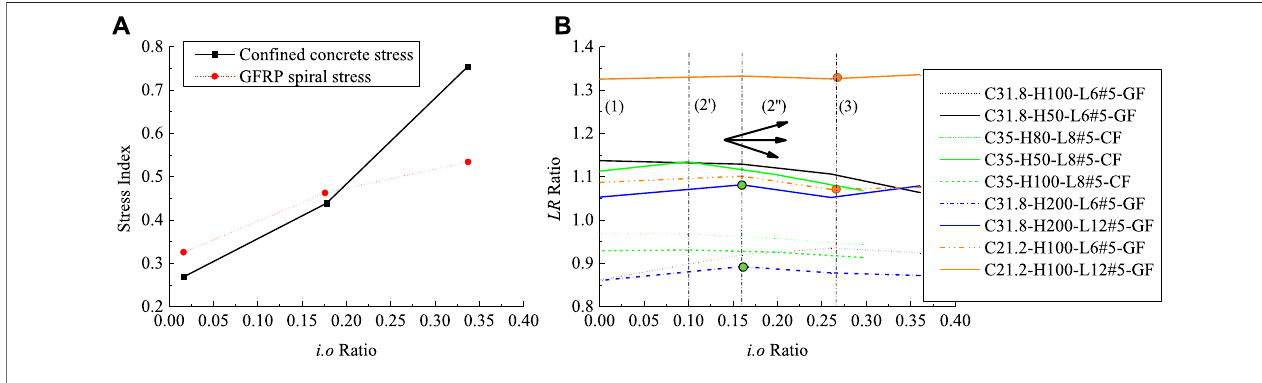
FIGURE 8 | The effect of increasing the i.o ratio on the experimental strength results for columns with varying concrete compressive strength and ratio of longitudinal and lateral reinforcement. (A) Test results from (AlAjarmeh et al., 2019a); (B) Results of Current simulated columns with different variations of test